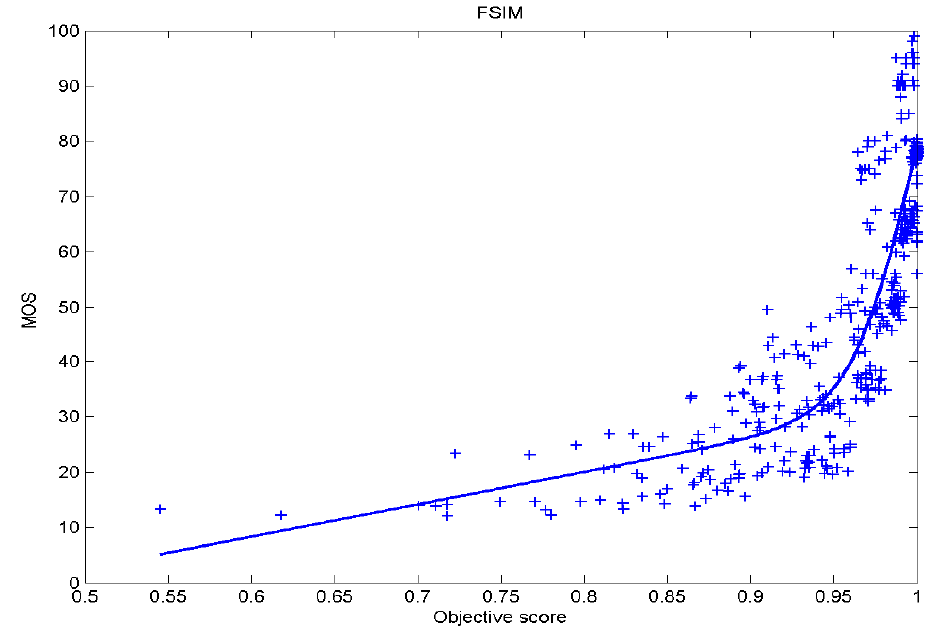
Figure 10. Scatter plots of the subjective scores (MOS) vs. FSIM.